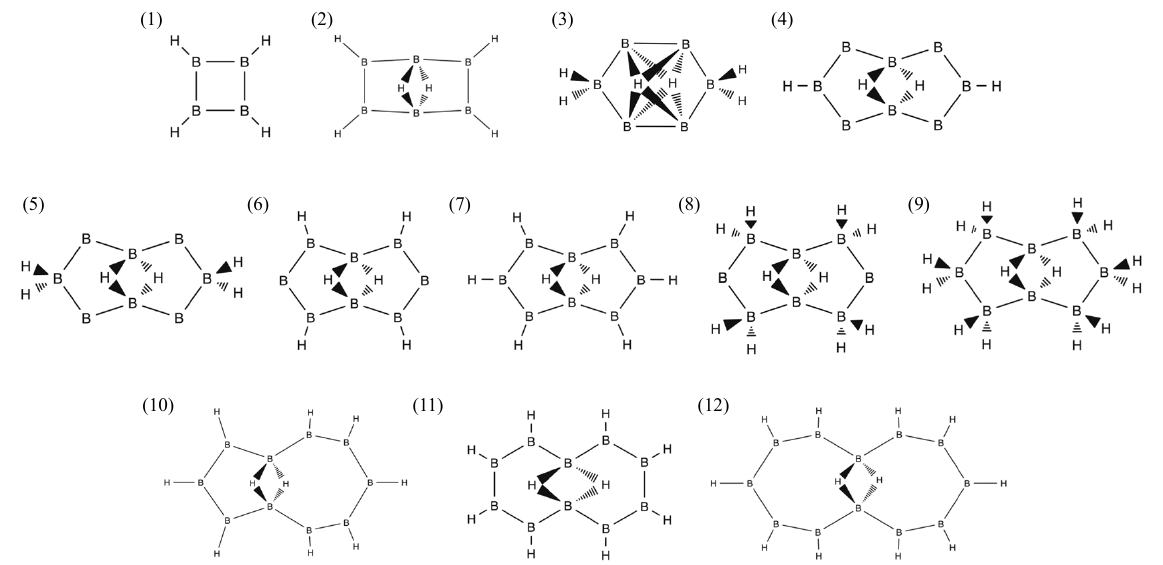
Figure 2. Structural formula of 12 candidates for a new cyclic hydrogenated boron molecule. A top-